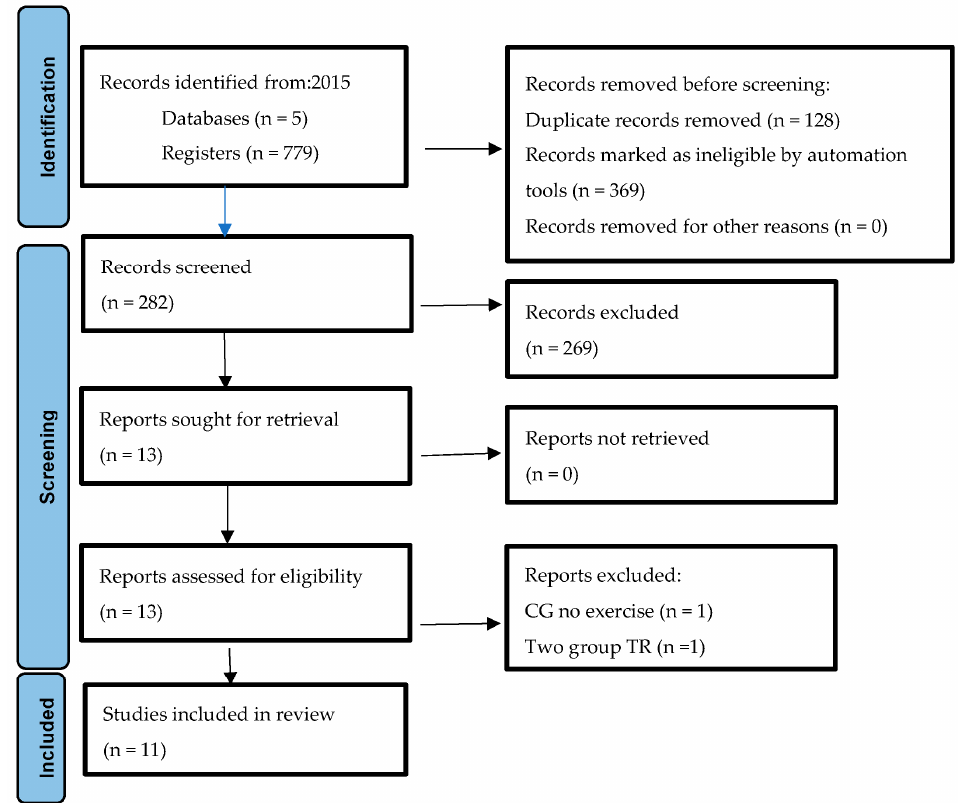
Figure 1. Flowchart diagram of the study.